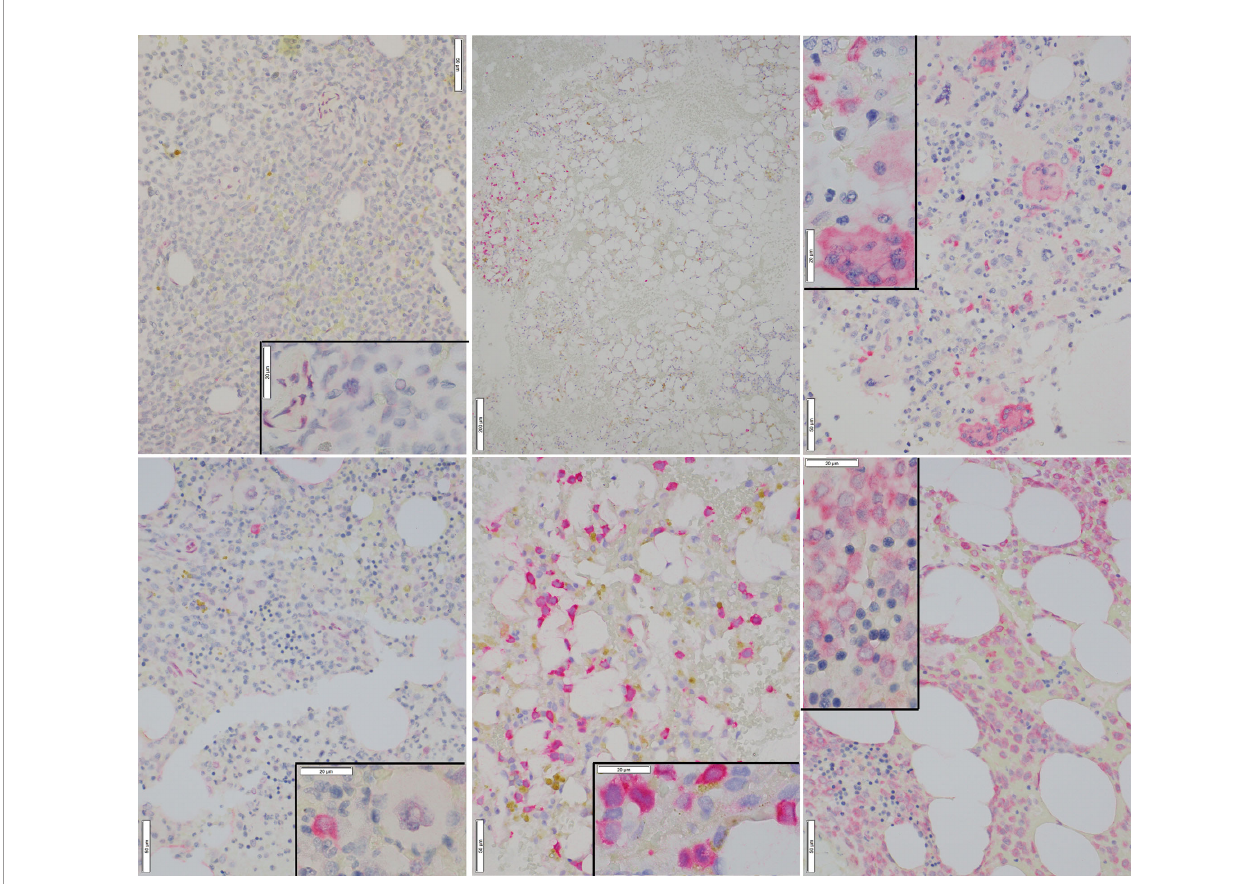
FIGURE 2 | Representative Images of Mutant NPM1 IHC. Top Left: Bone marrow negative for mutant NPM1 immunostaining (40x); inset (100x) shows lack of staining in hematopoietic cells; occasional background staining in vascular cells is noted. Bottom Left: Bone marrow borderline positive for mutant NPM1 immunostaining (40x); inset (100x) shows an immature hematopoietic cell which is positive for red, homogeneous cytoplasmic, mutant NPM1 immunostaining. Adjacent megakaryocyte is negative. Top Center: Bone marrow positive for mutant NPM1 immunostaining; this low power view (10x) shows patchy nature of staining; the cluster of red (positive) cells is noted on the left side of fi eld. Bottom Center: Bone marrow positive for red, homogeneous cytoplasmic mutant NPM1 immunostaining in hematopoietic cells(40x); inset(100x). Top Right : Bone marrow positive for mutant NPM1 immunostaining; scattered positive hematopoietic cells are seen admixed with scattered positive megakaryocytes (40x); inset (100x). Bottom Right: Bone marrow positive for mutant NPM1 immunostaining in a sample with a very high tumor cell burden; frequent positive hematopoietic cells are seen (40x); inset (100x): focally admixed mature erythroid elements (i.e., cells with small, round, hyperchromatic (i.e., dark blue) nuclei) are